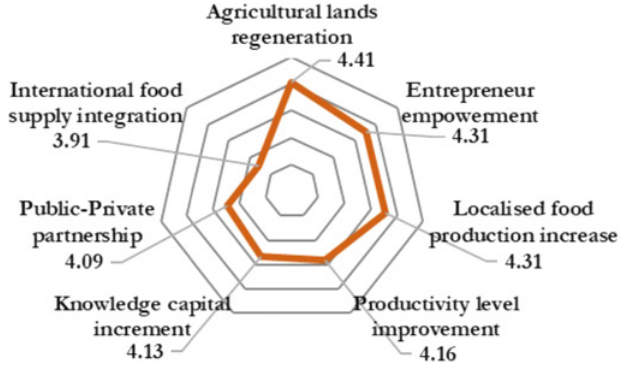
Figure 2 Influence of Food Security on Resilience